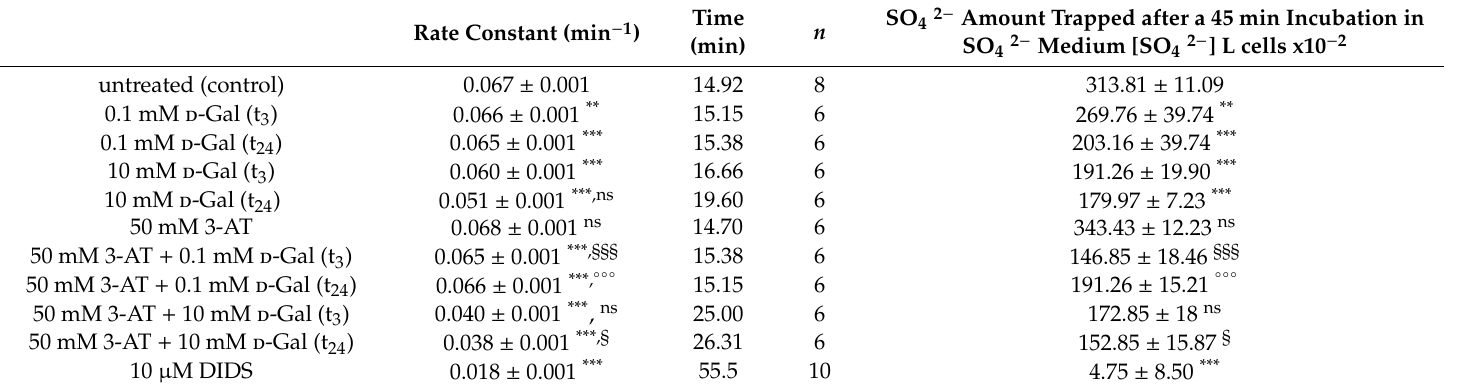
Table 1. Rate constant for SO 42 − uptake and amount of SO 42 − trapped in untreated and in d -Gal (t 3 or t 24 )-treated erythrocytes at di ff erent concentrations (0.1 or 10 mM), with or without 3-AT